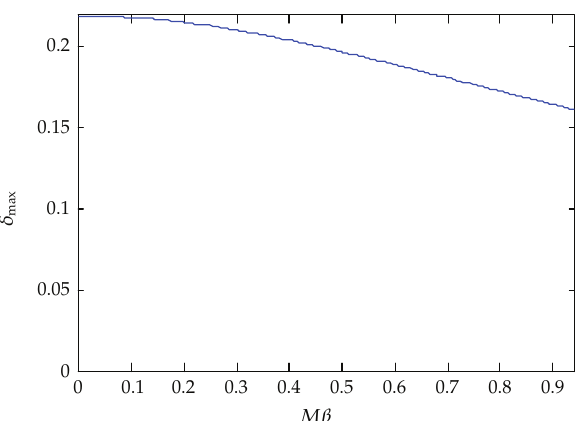
Figure 2: Upper bounds for (cid:5) G (cid:5) when Mβ ∈ (cid:2) 0 , 0 . 9398 (cid:3) .